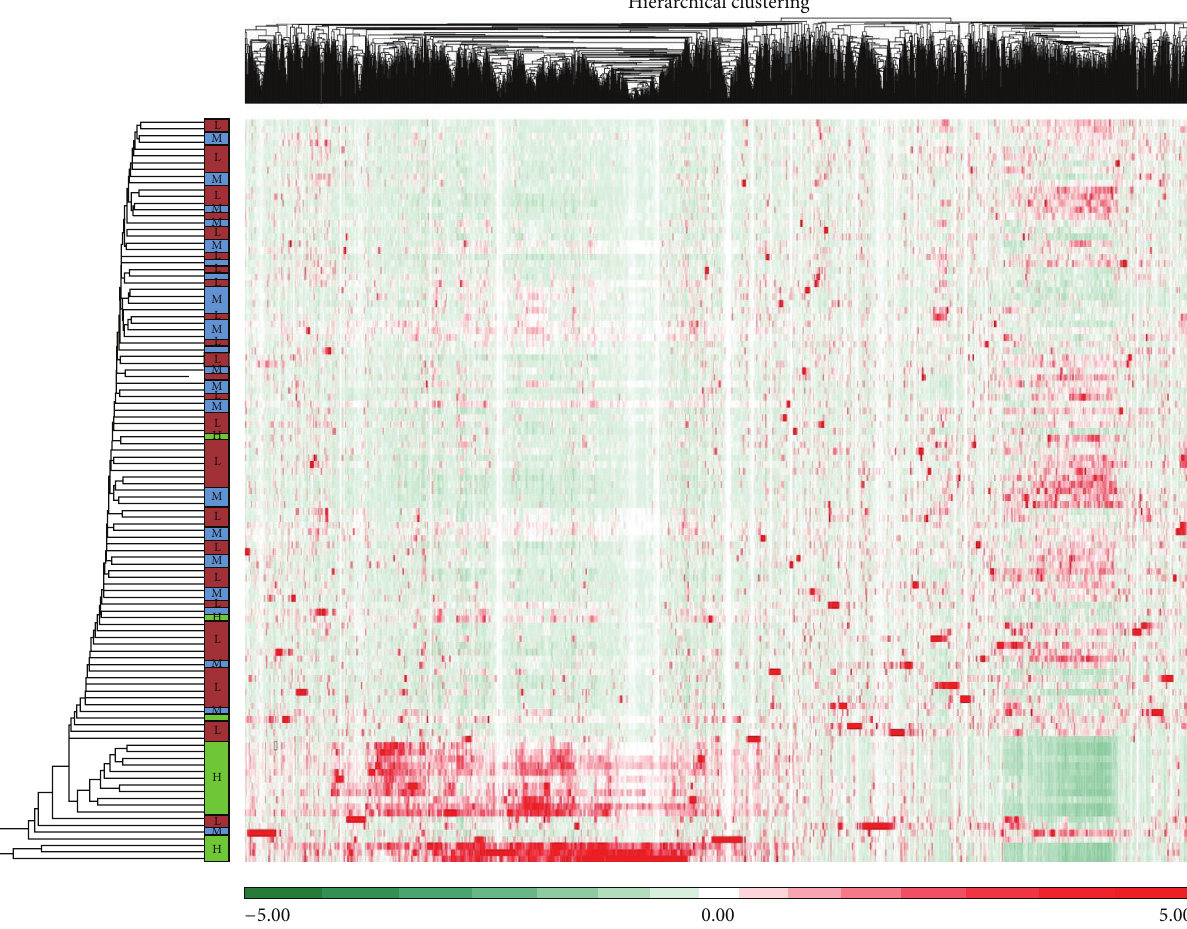
Figure 2: Hierarchical clustering of significant genes of SEMA6D-H versus -L expression. Genes (vertical: high expression in red and low expressioningreen)andsamples(horizontal:SEMA6D-highingreen,SEMA6D-mediuminblue,andSEMA6D-lowinbrown)wereclustered based on Euclidean dissimilarity matrix.